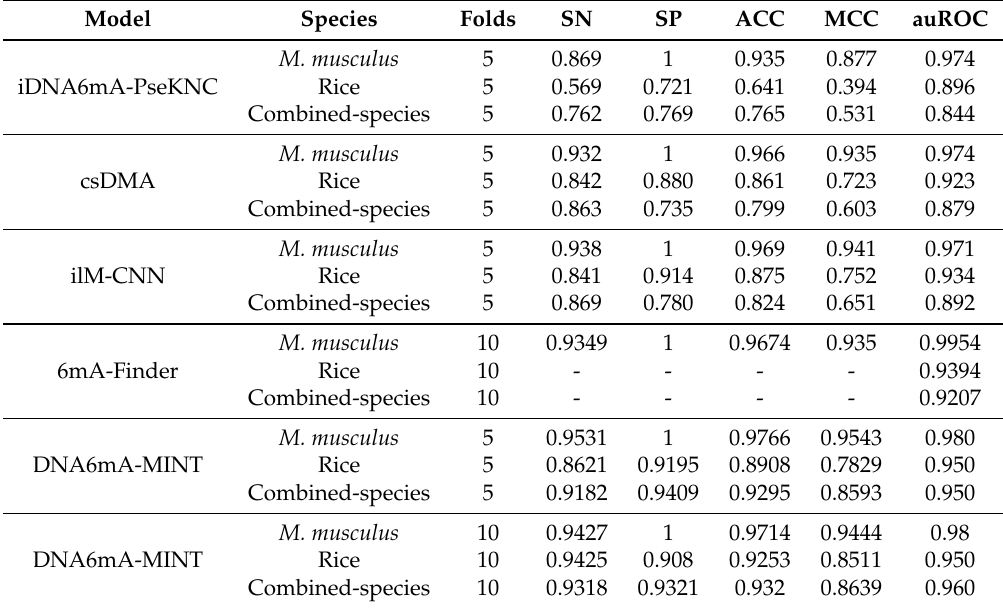
Table 2. Performance comparison of DNA6mA-MINT with existing techniques on different species with 5- and 10-fold